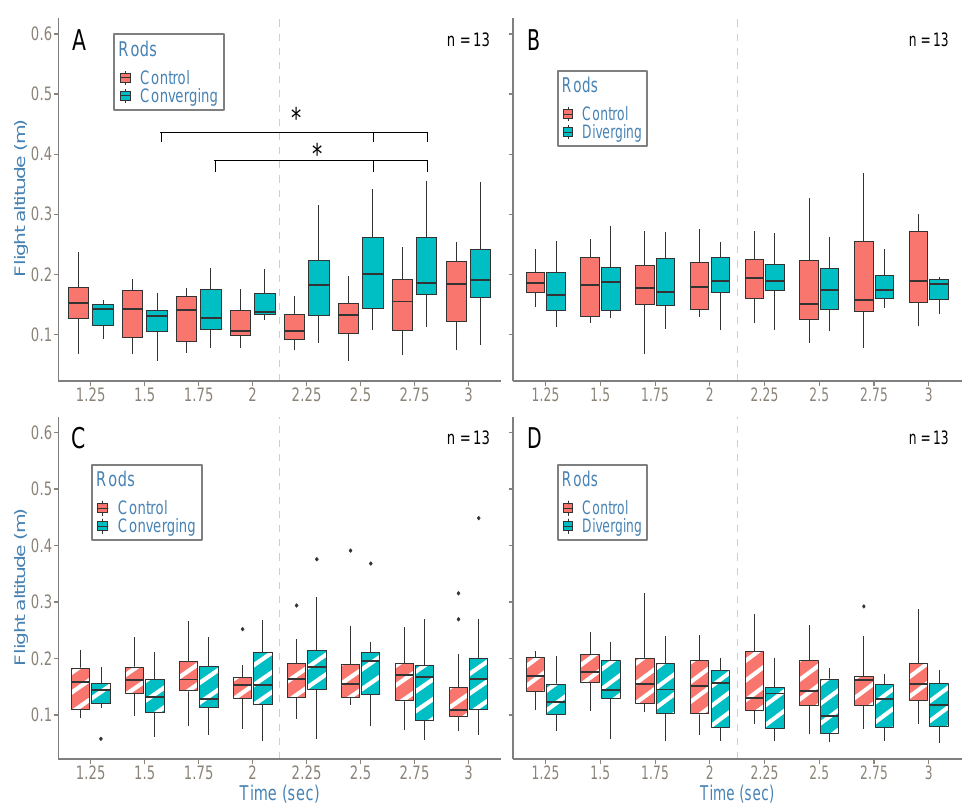
Figure 6. Altitude of bees subject to a splay angle manipulation. The four experimental conditions were ( A ) converging condition above white ground; ( B ) diverging condition above white ground; ( C ) converging condition above striped ground; ( D ) diverging condition above striped ground, compared to their respective control condition (parallel or narrow rods). The rods began to converge or diverge 2 s after bees entered the tunnel (blue dotted line), while they were flying through it. Above white ground, bees kept the same altitude in both the control conditions and the diverging condition (Figure 6A,B; for all comparisons p > 0.01). However, bees increased their altitude from 0.5 s to 0.75 s after the perturbation in the converging condition (Figure 6A; for all comparisons p < 0.01). Above striped ground, bees kept the same altitude in each condition and their respective control conditions (Figure 6C,D; for all comparisons p > 0.01). In all graphs, asterisks show significant differences between groups ( p < 0.01) and outliers are represented by solid circles. Randomly selected flights were analyzed in each condition, respecting a ground-following criterion (see Section 2.2.4). Raw trajectories from the trials are visible in Figures S1A,B and S2C,D. Data in ( A , B ) were already used in